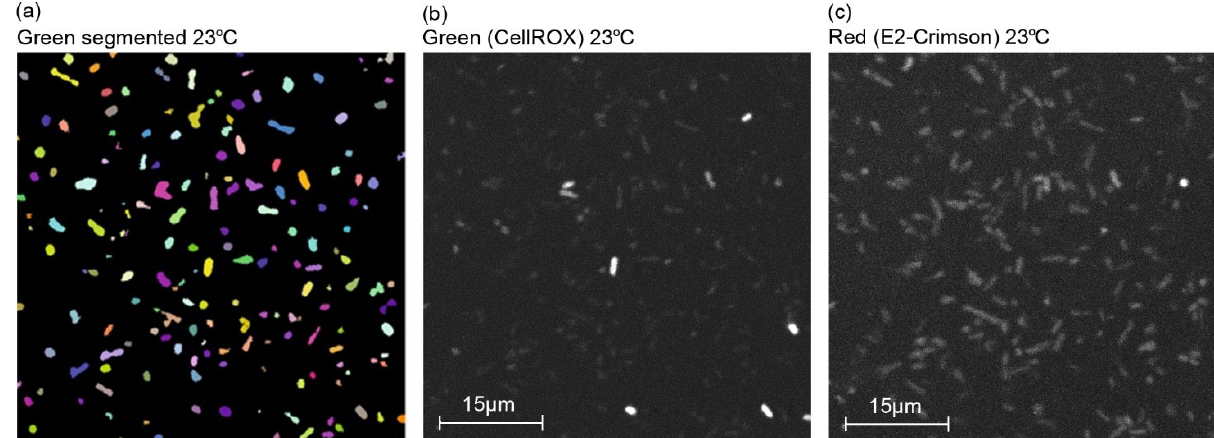
Figure 5. Representative confocal microscopy images of E. coli reporter strain DH5α /pJ404-IscR- C grown at 23 °C subjected to oxidative stress analysis . ( a ) Green fluorescence channel after segmentation with dynamic thresholding to separate bacteria from the background, ( b ) original image of the cells emitting green fluorescence corresponding to the ROS-sensitive commercial probe CellROX, and ( c ) original image of the cells emitting red fluorescence corresponding to the IscR- regulated E2-Crimson reporter system.